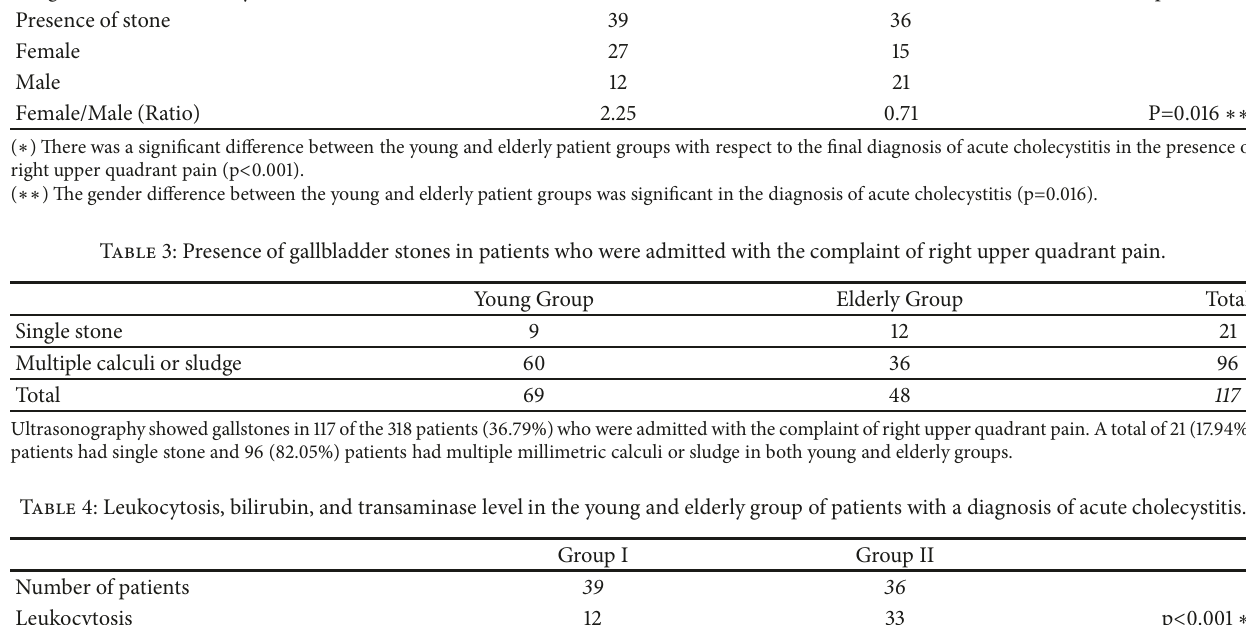
Table 2: Patients with diagnosis of acute cholecystitis in young (Group I) and elderly (Group II) patients with right upper quadrant pain. Patients with Right Upper Quadrant Pain